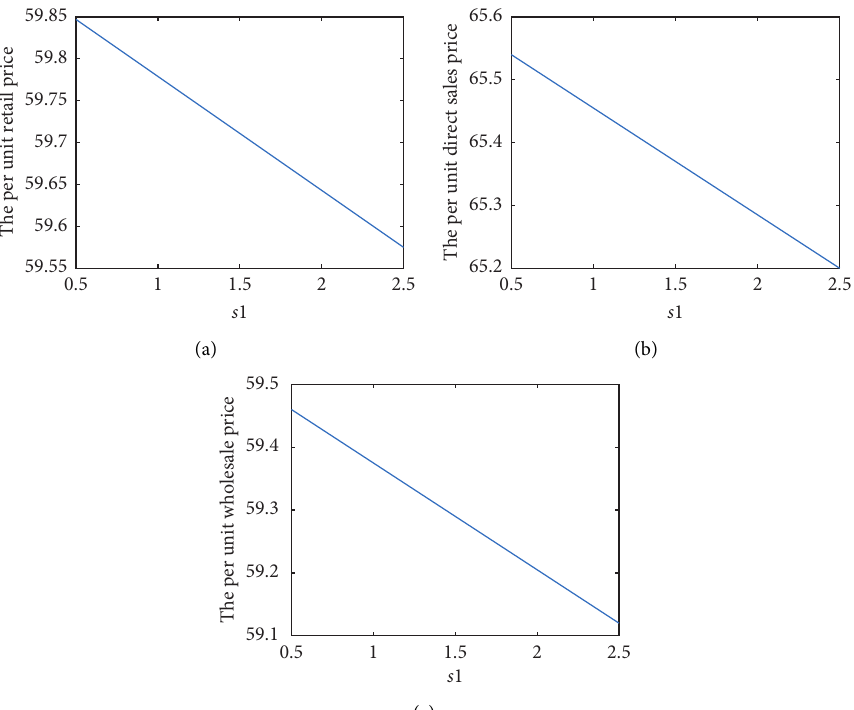
Figure 6: The effect of the government’s subsidy coefficient to the manufacturer s